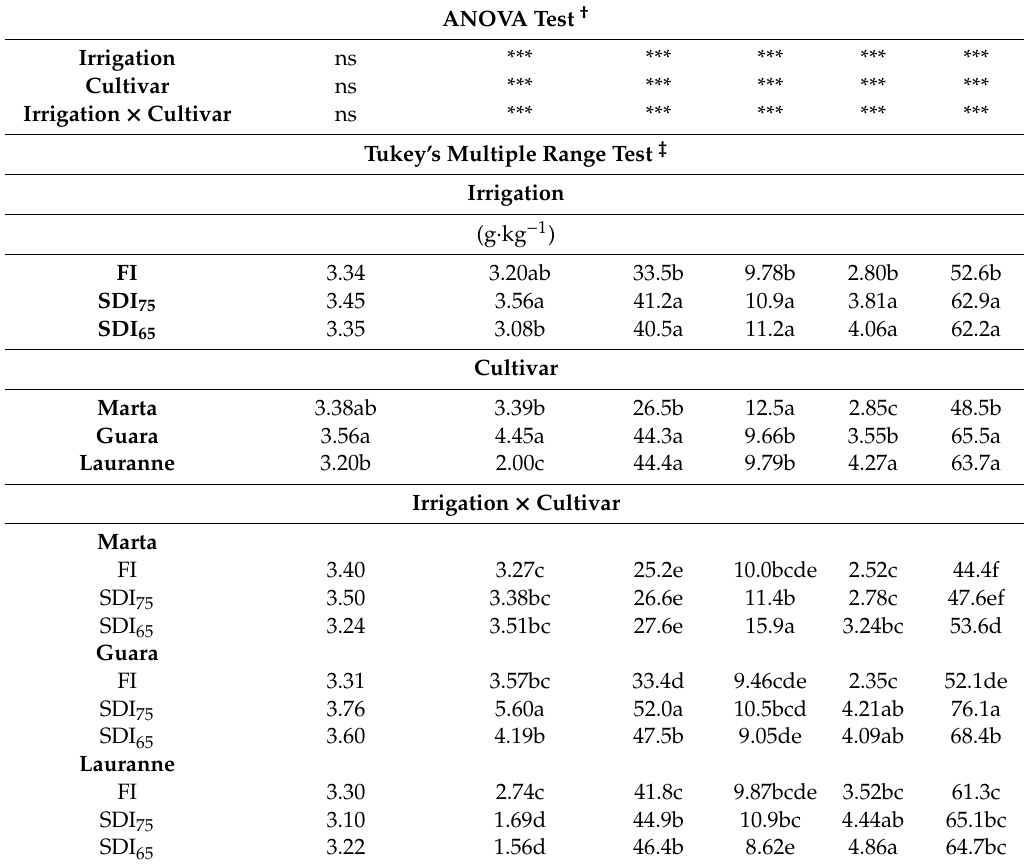
Table 5. Sugar content in raw almonds as a ff ected by irrigation dose and cultivar. Sugars Maltoheptaose